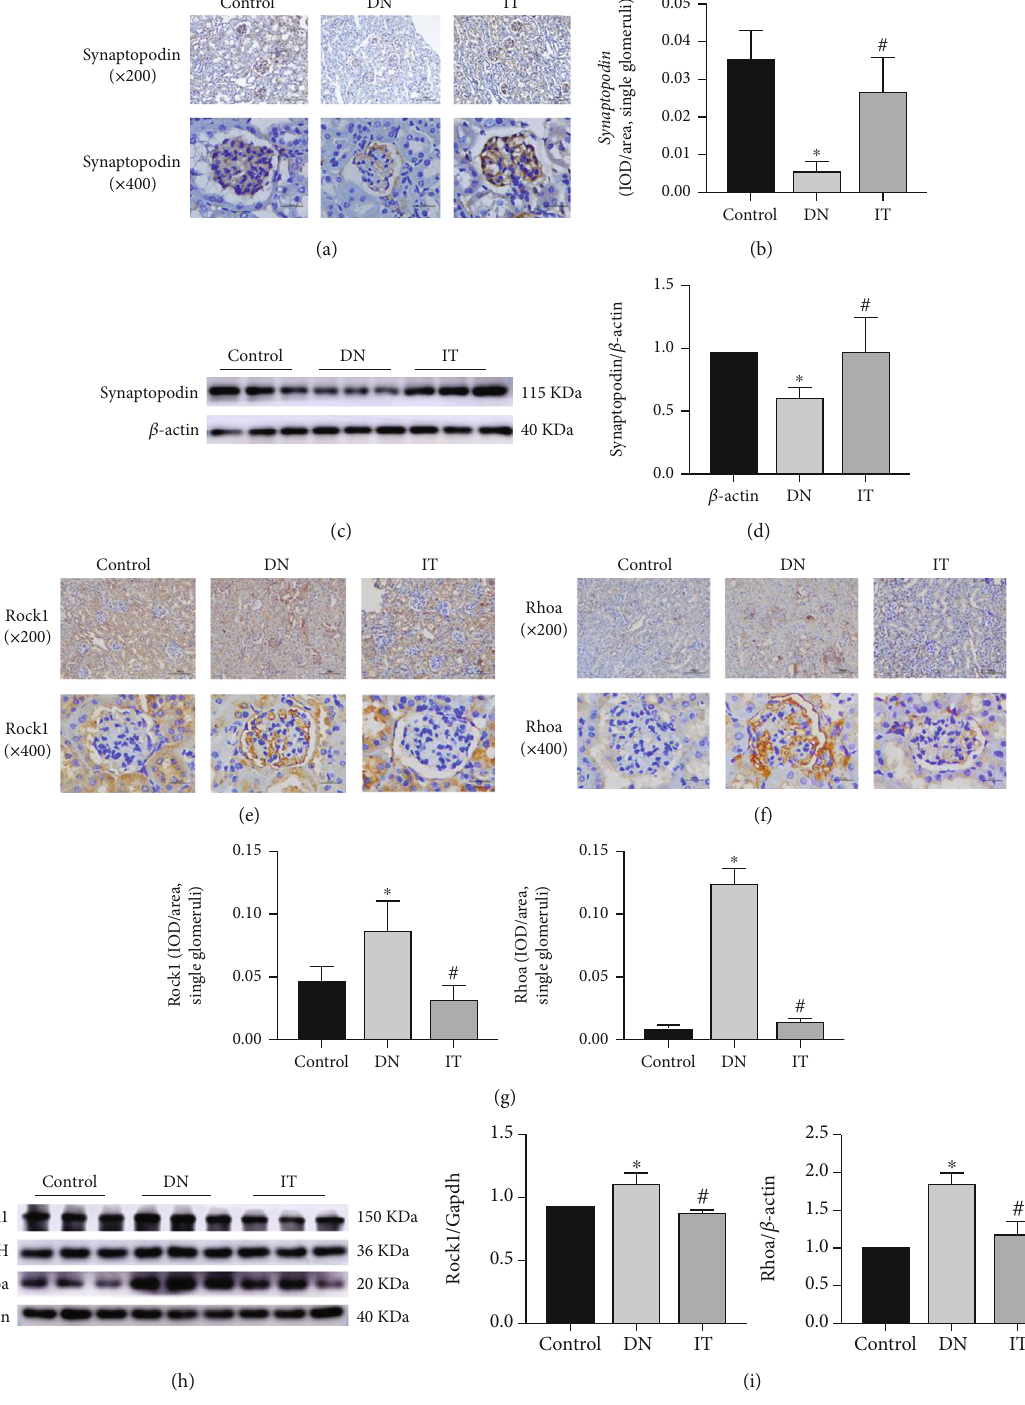
Figure 4: The e ff ects of islet transplantation on synaptopodin and RhoA/ROCK1 proteins in diabetic nephropathy mice. (a, b) Synaptopodin protein was detected by immunohistochemical staining ( × 200, × 400), and then, podocyte injury and restoration were quantitatively analyzed in di ff erent groups. Quanti fi cations of Synaptopodin protein expression in single glomeruli was measured by mean integrated optical density (IOD)/area. (c, d) Western blot was used to detect the expression of synaptopodin protein and quantitatively analyze recovery of podocytes after islet transplantation. (e, f) The expression and distribution of RhoA/ROCK1 proteins in immunohistochemical photographs ( × 200, × 400) of di ff erent kidney tissues. (g) Quanti fi cations of RhoA/ROCK1 proteins in single glomeruli was measured by mean integrated optical density (IOD)/area. (h, i) Western blot and semiquantitative analysis of RhoA/ROCK1 proteins expression in renal tissue ( ∗ P < 0 : 05 versus the control group, # P < 0 : 05 versus the DN